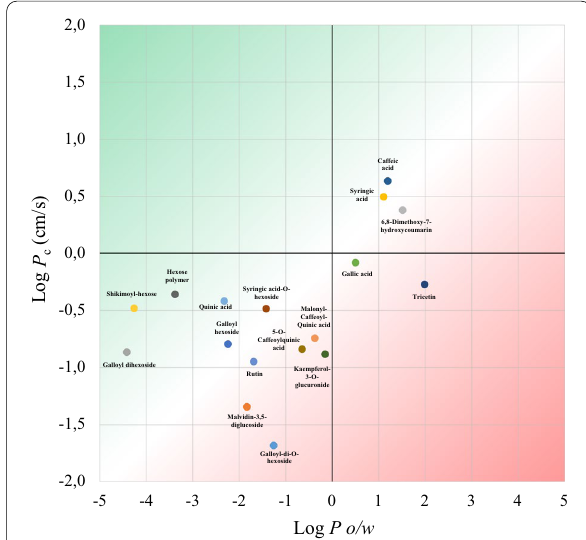
Fig. 3 Drug permeability in brain capillaries (log p c ) as a function of partition coefficient (log p